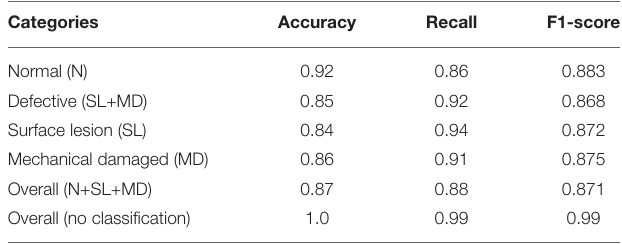
TABLE 1 | Performance evaluation of the detector